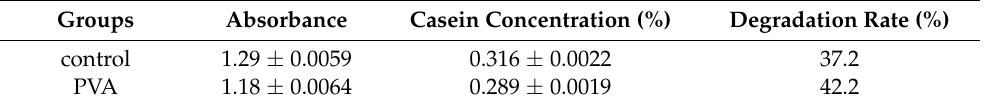
Table 5. Protein degradation assay.